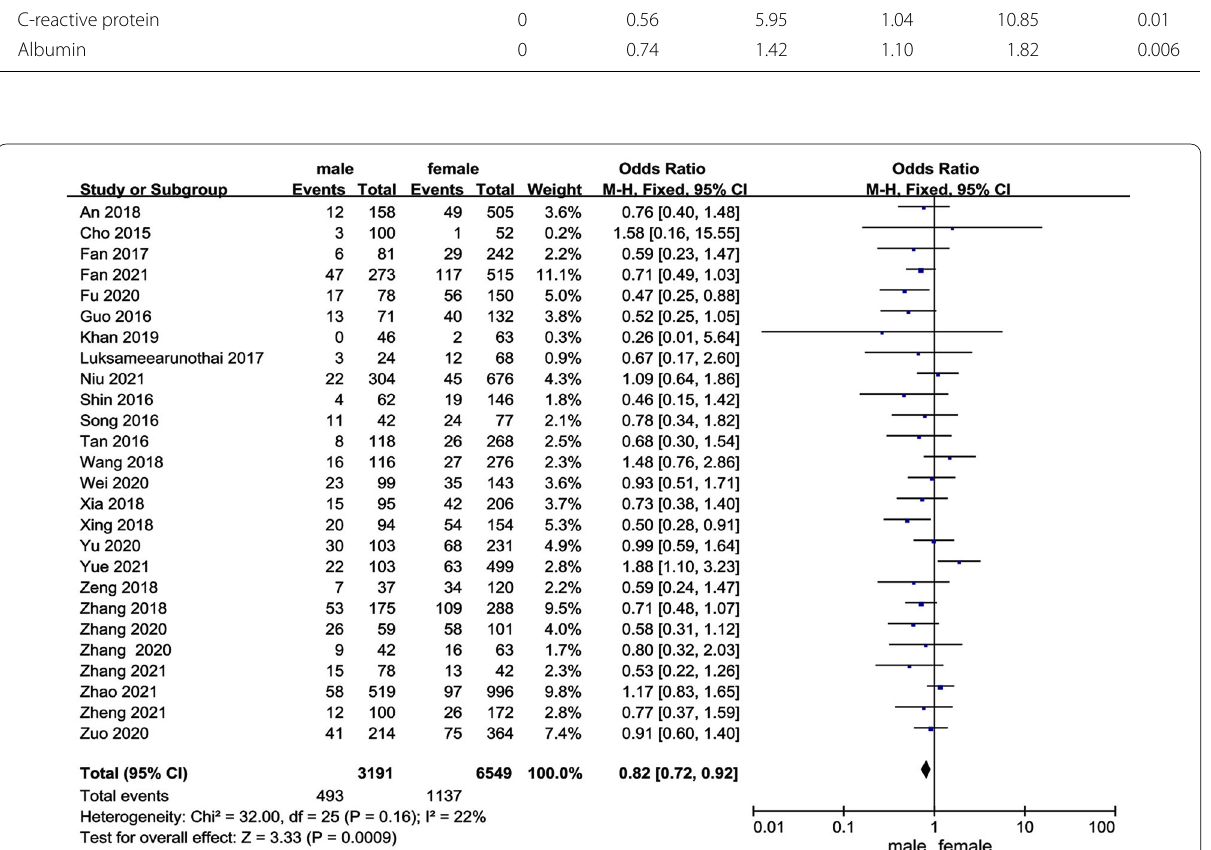
Thrombosis history